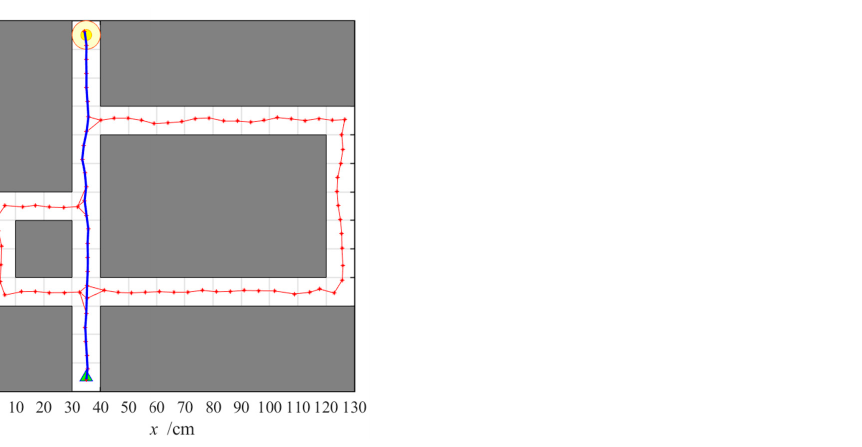
( d ) Figure 6. The generation process of the cognitive map; ( a – d ) are the cognitive maps when 24, 49, 74, and 90 place cells are activated, respectively. The reachable positions, the activated place cells and the links between them are marked by blue points, red asterisks and red lines, respectively. N at the top of each panel represents the number of activated place cells, and n represents the number of positions passed.